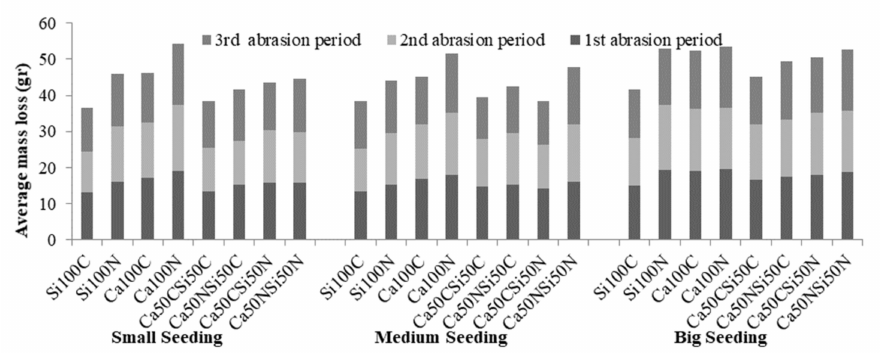
Figure 12. Abrasion resistance in form of average mass loss of seeding macro textures versus different mix